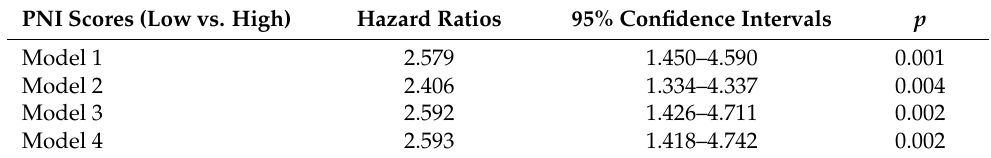
Table 2. Association between the prognostic nutritional index levels and major cardiovascular events risk. PNI Scores (Low vs. High) Hazard Ratios 95% Confidence Intervals